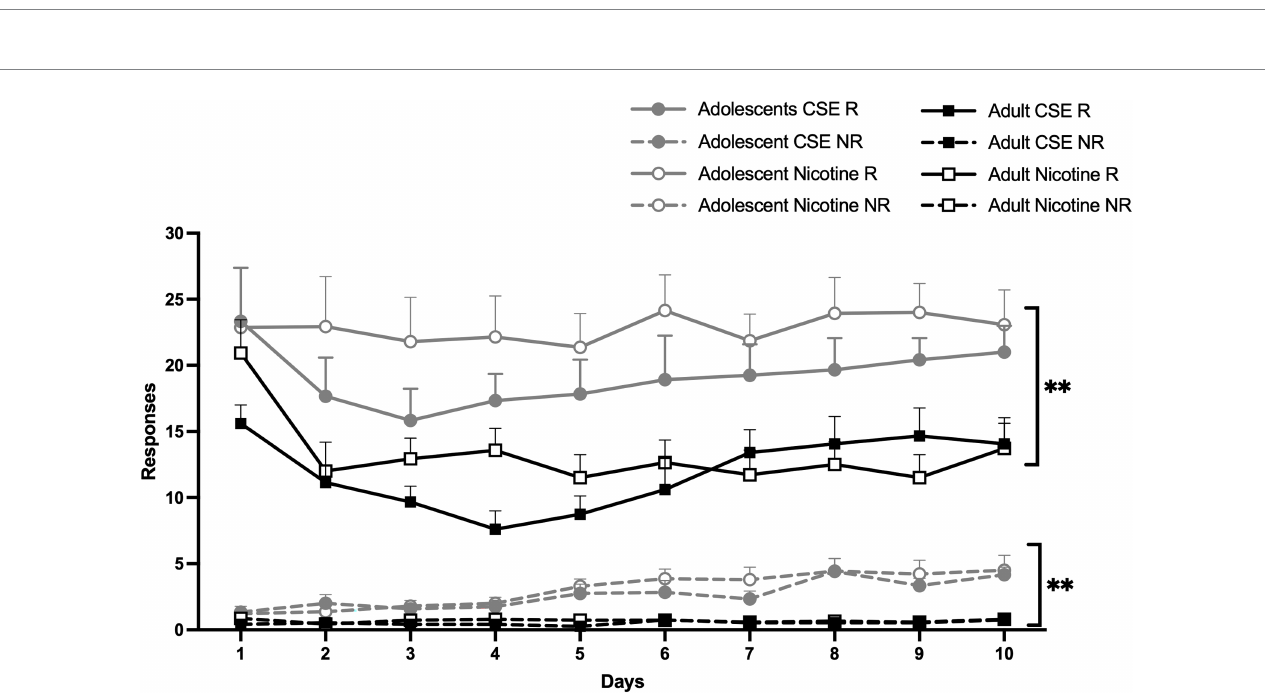
FIGURE 3 Age differences in the acquisition of self-administration. The lines represent mean (±SEM) responses leading to an infusion (R) of drug, nicotine or CSE, or not (NR) for adolescent (gray lines) and adult (black lines) rats. Open circles and open squares represent nicotine; closed circles and closed squares represent CSE. ** p < 0.005 vs. adult, on all days except Day 1. n = 12–15 per